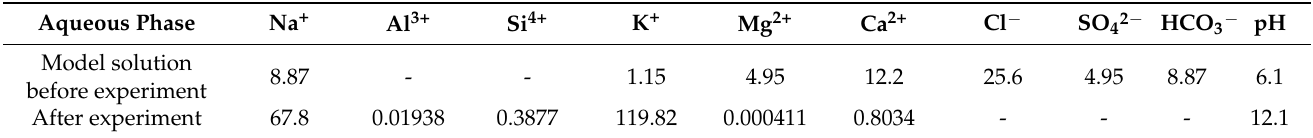
Table 6. Composition of the model solution of the underground water of the «Yeniseysky» site before and after the experiment (10 − 4 , mol/L)